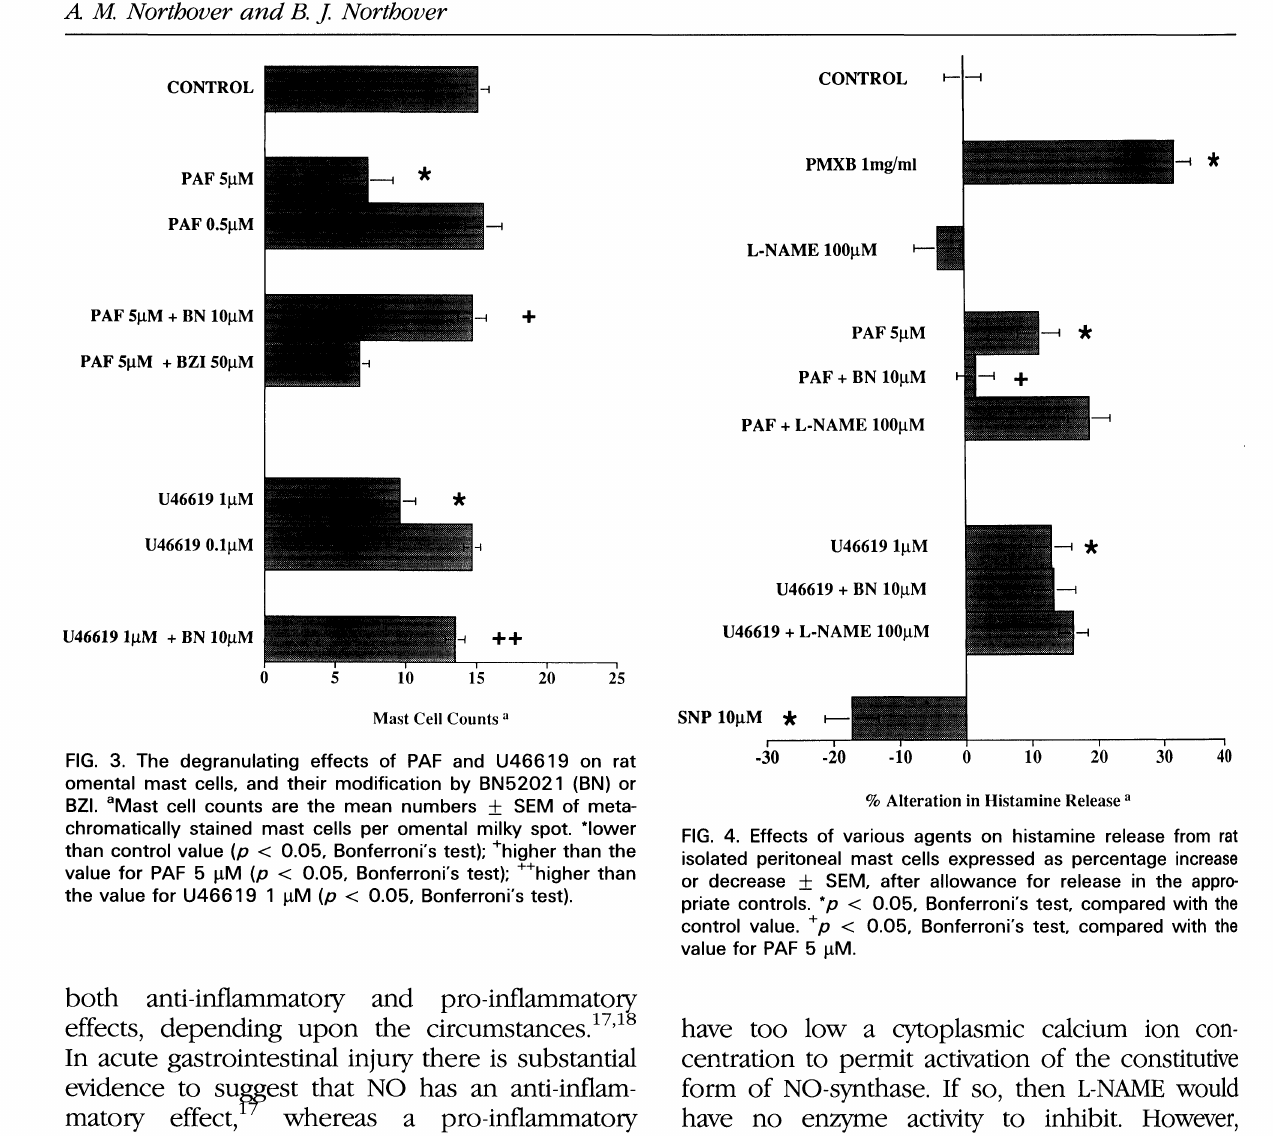
___ SEM of meta- FIG. 4. Effects of various agents on histamine release from rat isolated peritoneal mast cells expressed as percentage increase or decrease -t- SEM, after allowance for release in the appro- priate controls. *p < 0.05, Bonferroni’s test, compared with the +p < 0.05, Bonferroni’s test, compared with the control value. value for PAF 5